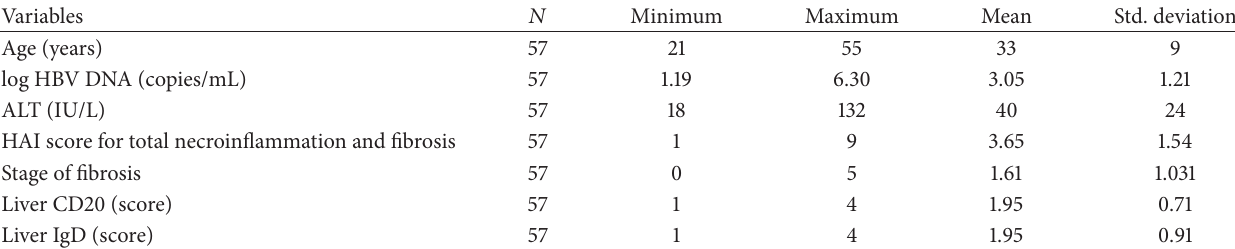
Table 1: Descriptive statistics of clinical and pathological variables in 57 chronic hepatitis B